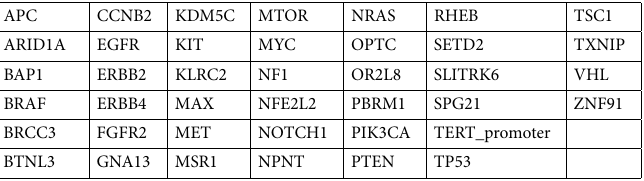
Table 2. List of genes for targeted deep